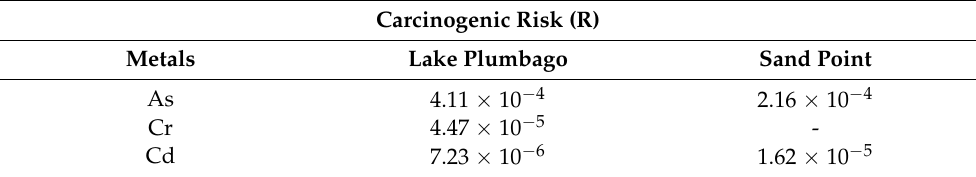
Figure 4. Hazard Index (HI) values indicate non-carcinogenic health risk due to exposure to toxic elements from the ingestion of wild rice seeds obtained from Lake Plumbago and Sand Point sloughs. Carcinogenic risk for the toxic metals As, Cr, and Cd was calculated according to USEPA, 2019 [18]. The mean risk levels from As for rice seed samples from Sand Point and Lake Plumbago were 2.16 × 10 − 4 and 4.11 × 10 − 4 , respectively (Table 3). For Cr, the risk from oral ingestion of wild rice seed samples from Lake Plumbago was 4.47 × 10 − 5 . The Cr level in rice seed samples from the Sand Point site was below the detection limit. For Cd, the carcinogenic risk levels were 7.23 × 10 − 6 and 1.62 × 10 − 5 from wild rice seeds harvested from Lake Plumbago and Sand Point, respectively. According to USEPA [16] the regulatory values for As, Cr, and Cd are 1 × 10 − 6 to 1 × 10 − 4 , so the consumption of rice seeds from both locations poses a lifetime cancer risk for As and Cd, whereas, for Cr, only the Lake Plumbago wild rice seeds pose a carcinogenic risk. Table 3. Excess cancer risk (R) values for As, Cr, and Cd from the ingestion of wild rice grains growing in Lake Plumbago and Sand Point sloughs.